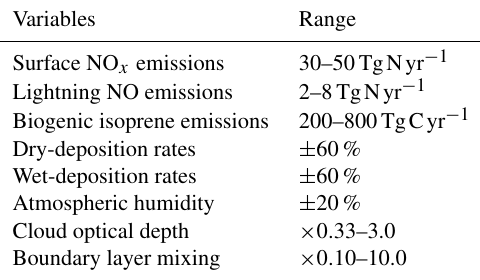
Table 2. Variables and uncertainty ranges used in this study